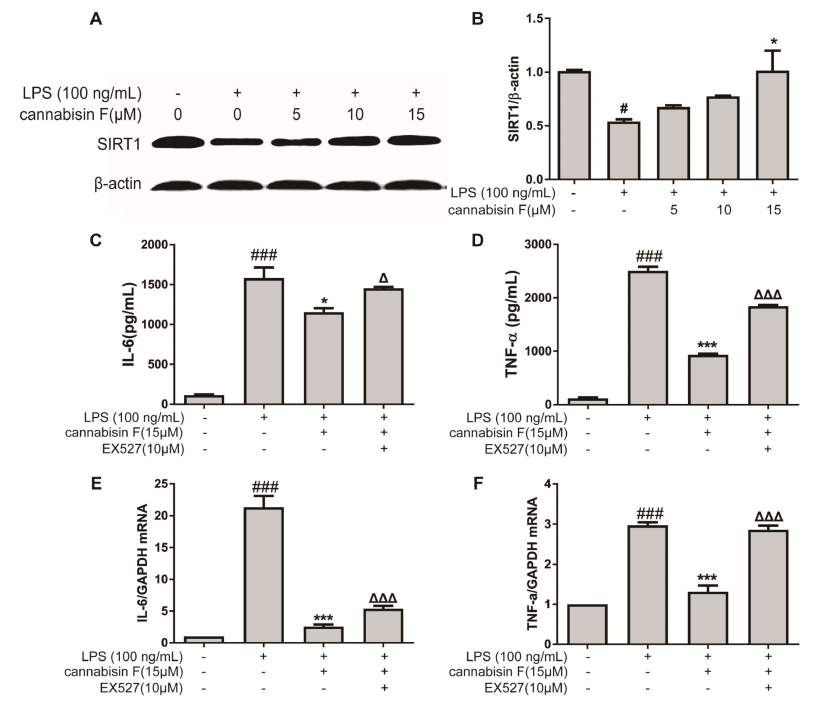
Figure 6. Cannabisin F increased the expression of SIRT1 and SIRT1 inhibitor EX527 reversed anti-inflammatory action of cannabisin F. ( A and B ) Cannabisin F enhanced expression of SIRT1. BV2 cells were pretreated with cannabisin F (5, 10 and 15 µ M) for 1 h prior to stimulation with LPS at 100 ng/mL for 24 h. Cell extracts were harvested and subjected to Western blot with antibodies against SIRT1. β -actin was used as the internal control for normalization. ( C – F ) EX527 reversed the anti-inflammatory activity of Cannabisin F in LPS-stimulated BV2 microglia cells. BV2 cells were pre-treated with EX527 at 10 µ M for 1 h, followed by treatment with cannabisin F for 1 h and then stimulation with LPS at 100 ng/mL for 24 h. Culture supernatants were harvested and analyzed for IL-6 ( C ) and TNF- α ( D ) as measured by ELISA. The mRNA levels of IL-6 ( E ) and TNF- α ( F ) were determined by qRT-PCR. The data are presented as mean ± SD from at least three independent experiments. (cid:52) p < 0.05, (cid:52)(cid:52)(cid:52) p < 0.001 as compared to the cells treated with LPS and cannabisin F; * p < 0.05, *** p < 0.001 as compared to the cells treated with LPS; # p < 0.05, ### p < 0.001 as compared to the